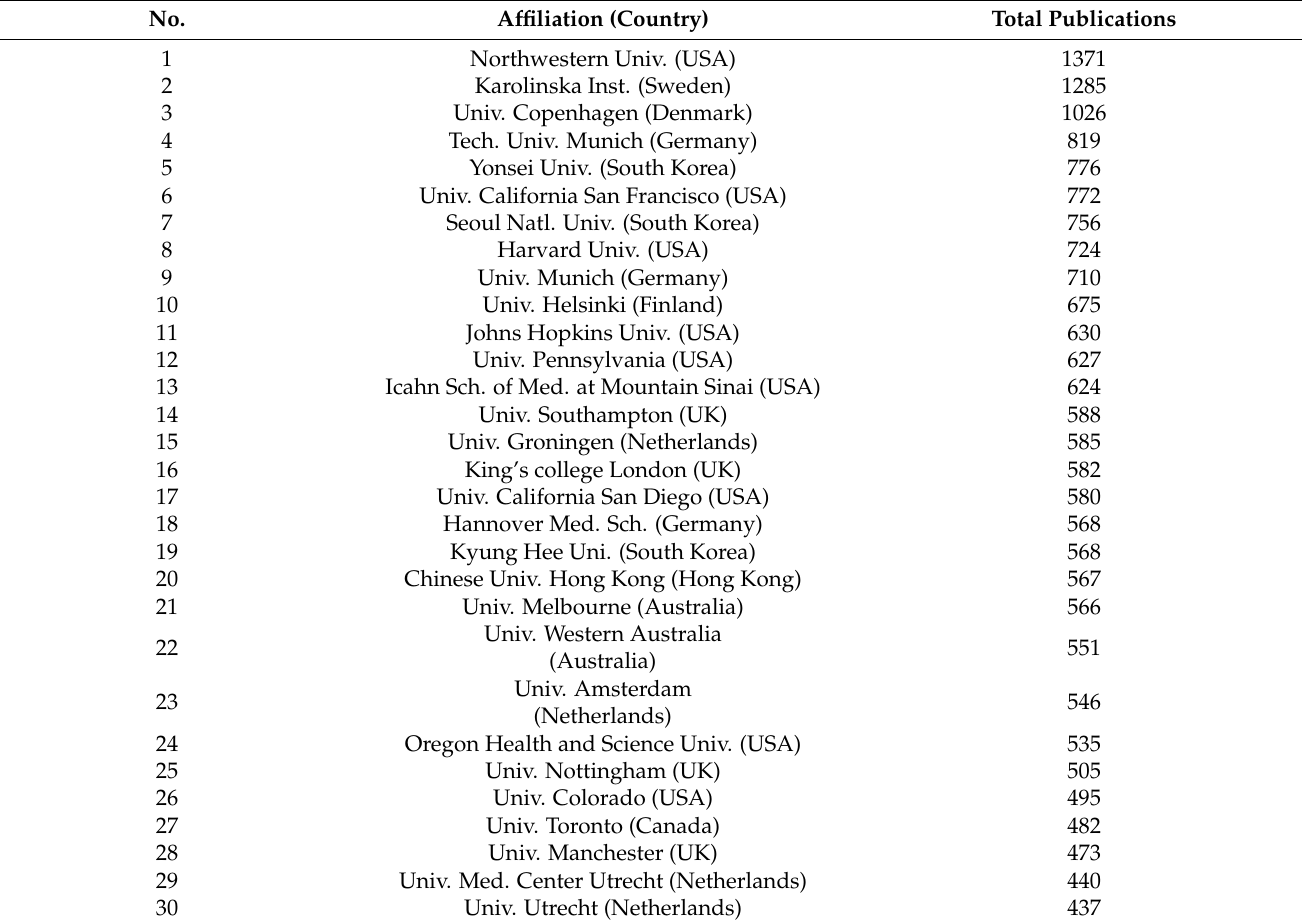
Table 3. The total number of publications from the top 30 affiliations during the period 1990–2020.